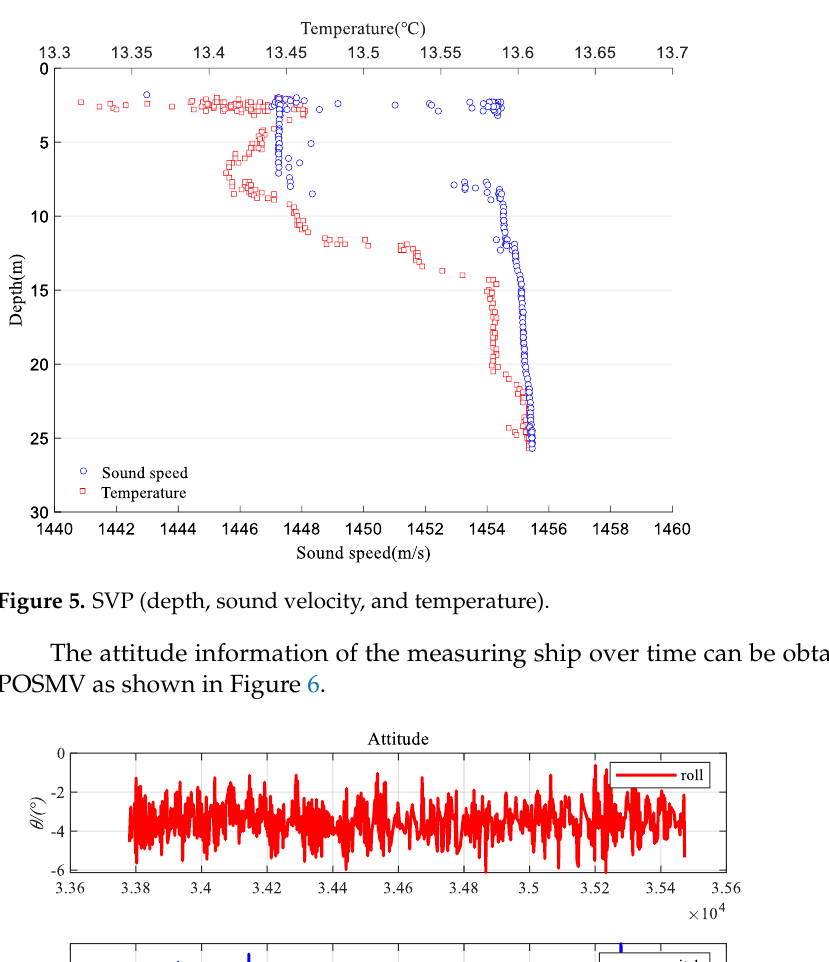
Figure 6. Changes of the three attitude angles.